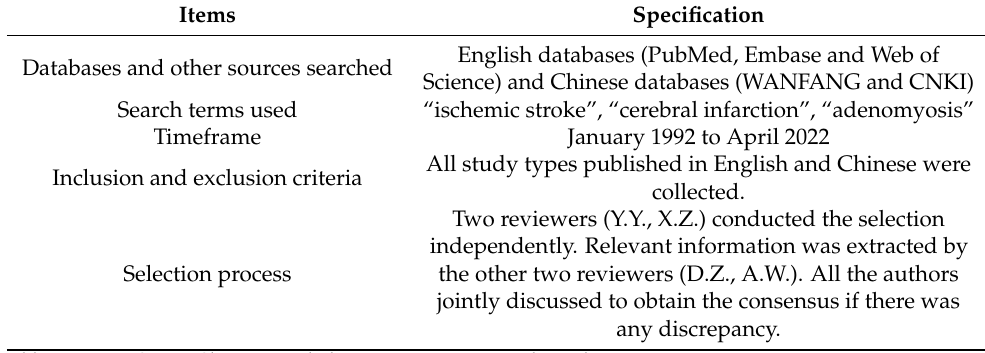
Table 2. Summary of search